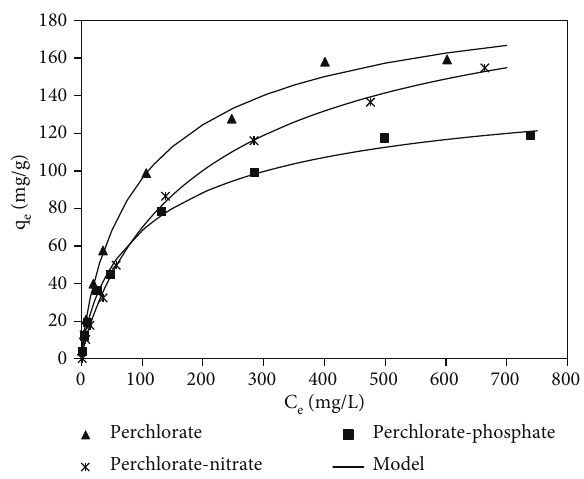
Figure 3: E ff ect of anions on perchlorate adsorption by MR and the fi tted L-F model. Initial ½ NO 50 mg/L.